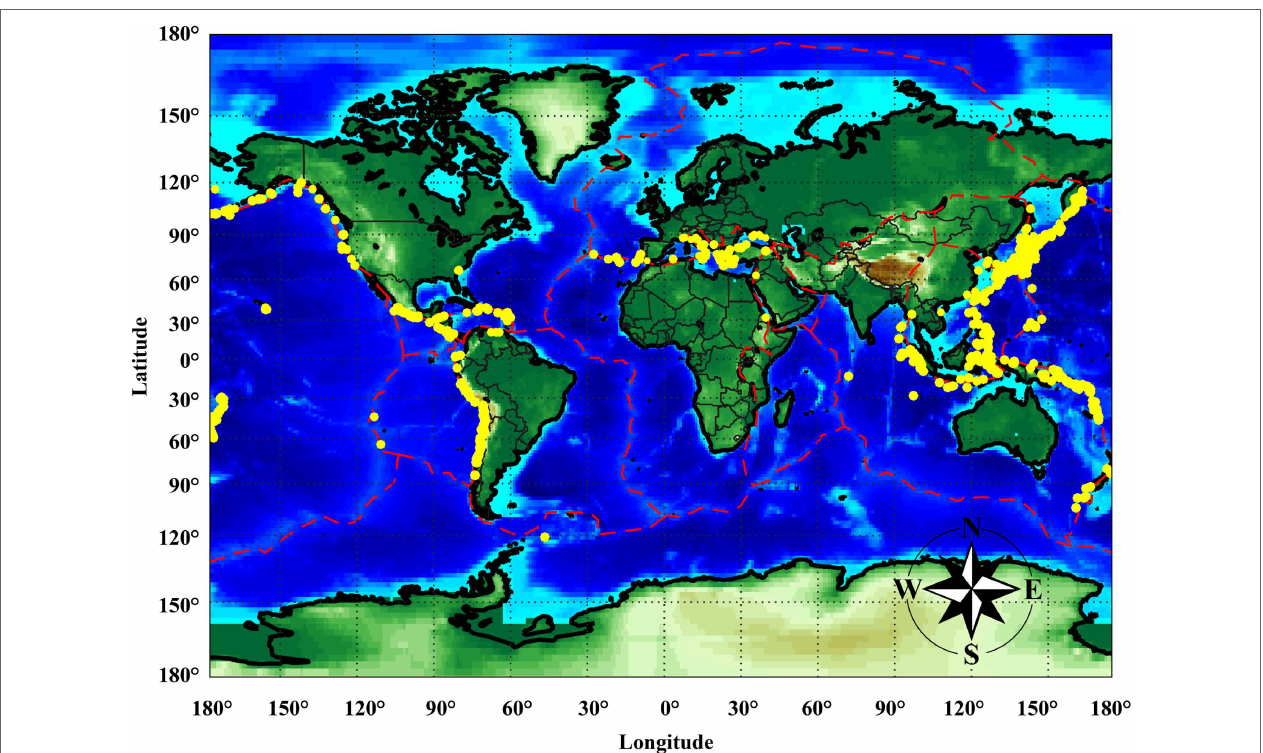
FIGURE 1 | Locations of tsunamis triggered by seismic events . The red lines represent the global plate